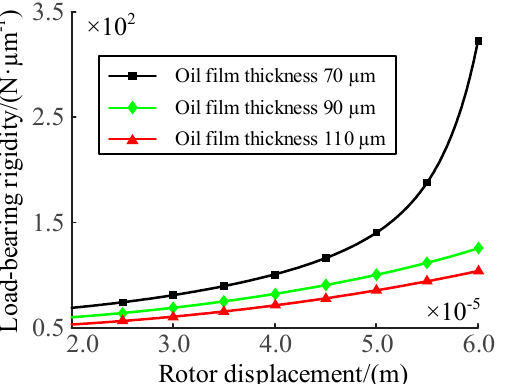
Figure 9. Relation curve between bearing stiffness and rotor displacement under different oil film thickness.